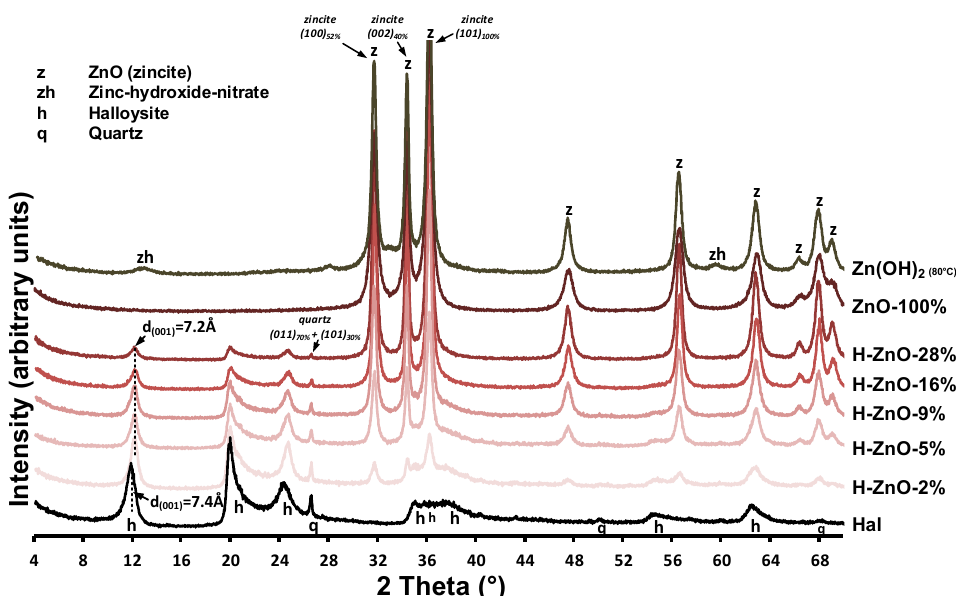
Figure 1. Structural and compositional characterization of the untreated halloysite, Zn(OH) 2 sample and their heat-treated composites (T = 350 °C) with different Zn content by powder X-ray diffraction measurements. The most intense reflections of quartz and zincite are designated along with the corresponding Miller indices while the dashed line indicates the d (001) value of halloysite and its shift upon dehydration.